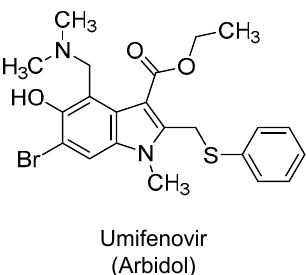
Figure 6. The chemical structure of umifenovir (abidol), an antiviral drug with multiple antiviral mechanisms of action. The drug is being tested alone or in combination with other potential therapeutics for the treatment of COVID-19 patients.